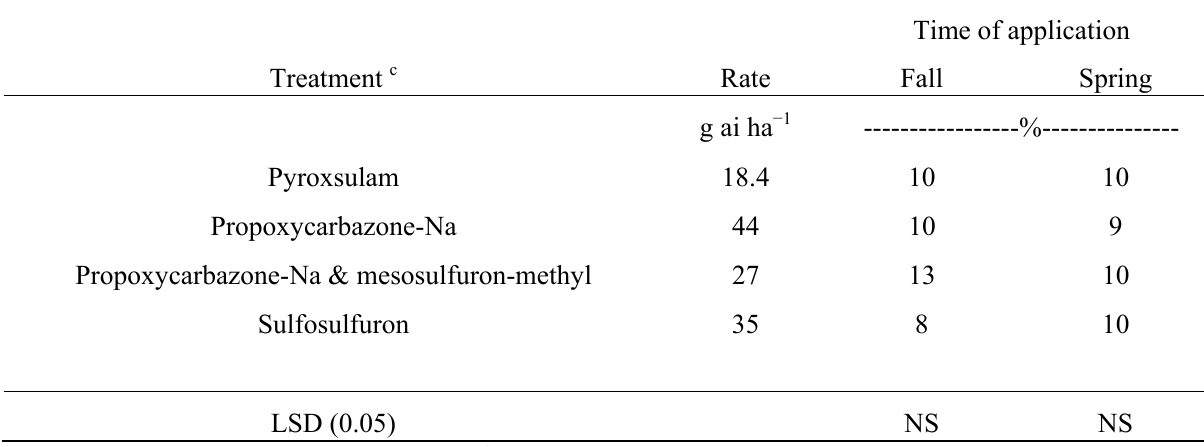
Table 5. Wheat injury at 14 days after treatment caused by ALS-inhibiting herbicides applied in fall and spring seasons, Hays, KS a, b